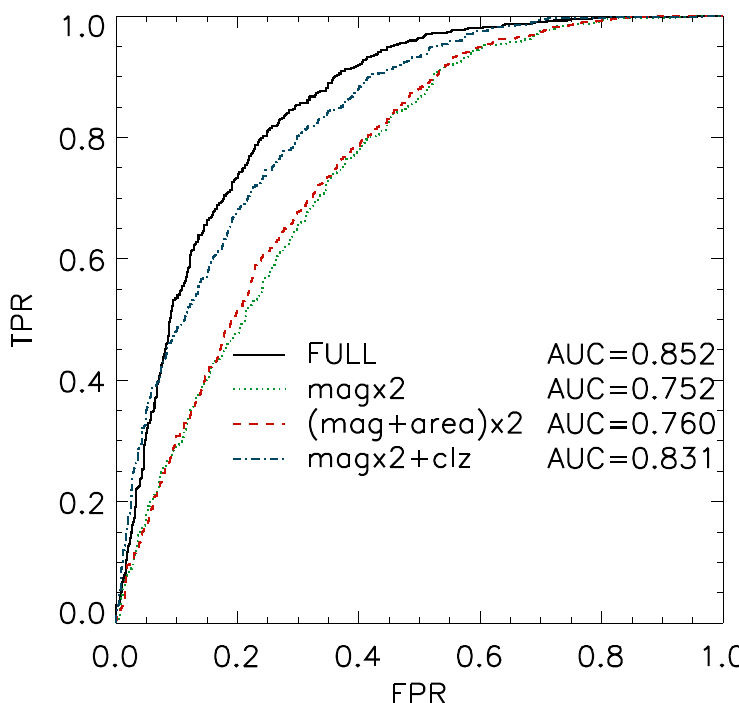
Figure 3. The ROC curves for various input measures. The label ‘area’ is the ISO_AREA_IMAGE, while the label ‘clz’ is the redshift of each cluster. The label ‘magx2’ means that the model is trained with only MAG_AUTO in two bands. The label ‘FULL’ means that the model is fed all of the measures for training, i.e., MAG_AUTO, ISO_AREA_IMAGE, CONC, FWHM_IMAGE, ELLIPTICITY, MAG_APER, BACKGROUND, ASYMMETRY in both bands, and